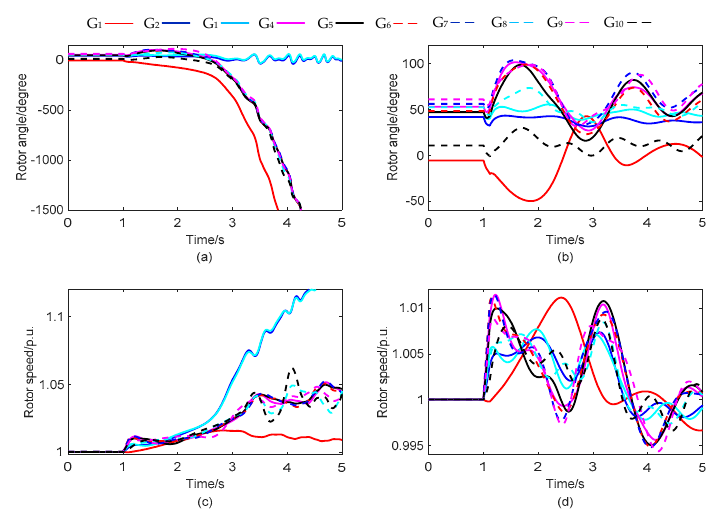
Figure 7. Dynamics of the generator ( a ) rotor angle and ( c ) rotor speed without PEC; Dynamics of the generator ( b ) rotor angle and ( d ) rotor speed with PEC.